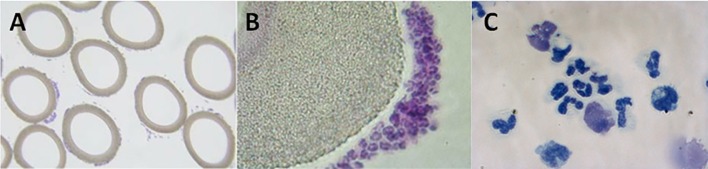
Micrographs of cross-sectional area of sham, acellular cartridges (as part of the regional citrate anticoagulation arm of the Renal Assist Device clinical trial now known as the selective cytopheretic device) (A,B). Low-power micrograph showing adherent cells around each fiber (A, 4× objective). Higher-power micrograph showing clustering of bound leukocytes (B, 20× objective). High-power micrograph of a cytospin prepared from adherent cells washed from the outer membrane of the SCD after 24 h of therapy on the first pediatric patient (C, 63× objective). Patient treatment demonstrated adherent leukocytes with a predominance of neutrophils and monocytes on the outer surface of the membranes along the blood flow path which translated into patient benefit.